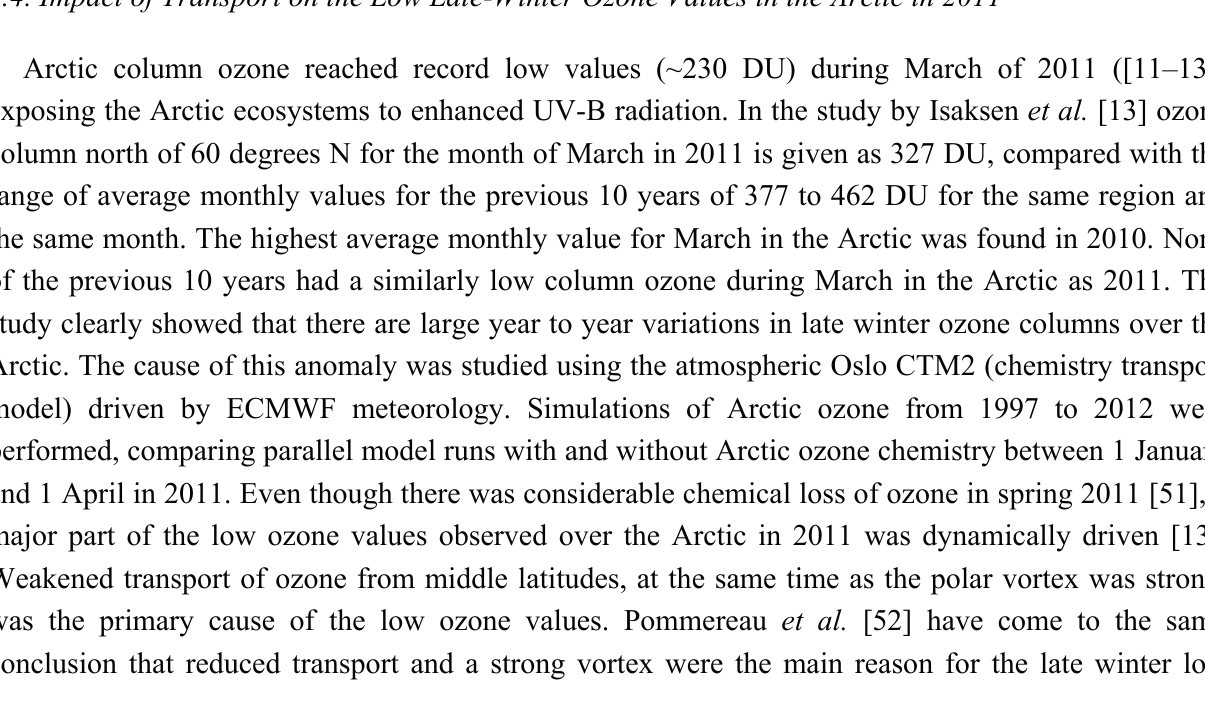
, the tropospheric increase of ozone 4